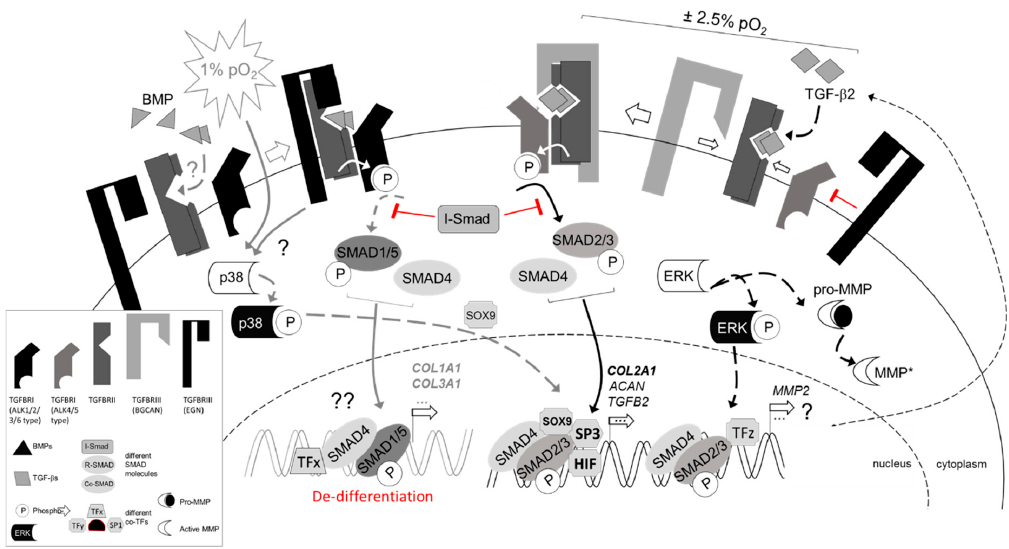
Figure 8. Simplified schematic of proposed TGF ‐β signal transduction under physoxic conditions. TBSF signaling is mediated via specific heteromeric complexes of type I (activin A receptor type II ‐ like kinases, ALKs) and type II (TGFBRII) serine/threonine kinase receptors. Canonically, TGF ‐β